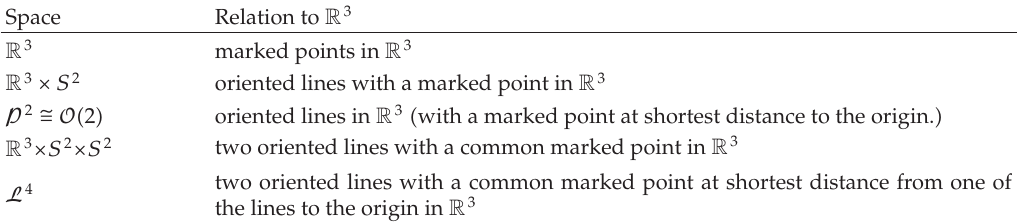
Space Relation to R 3 marked points in R